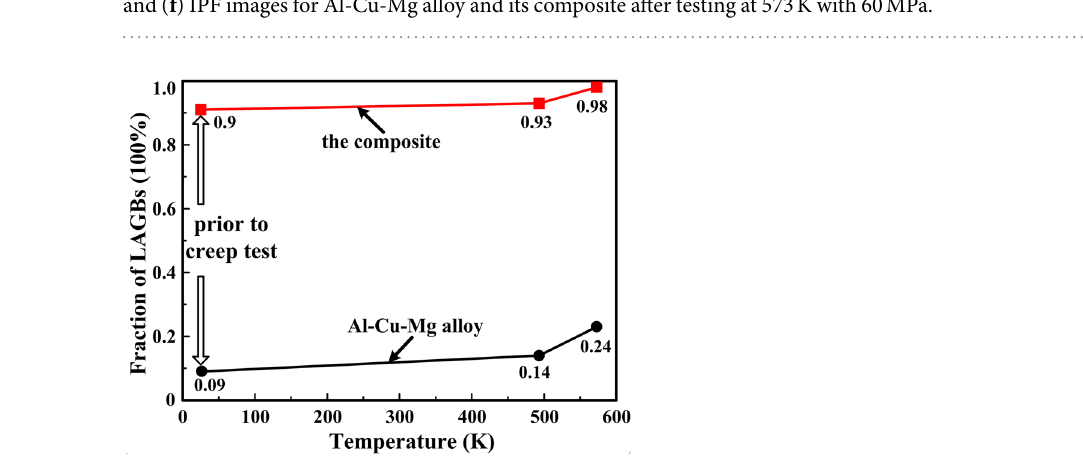
Figure 7. Variation of the fraction of LAGBs with the temperature for Al-Cu-Mg alloy and the